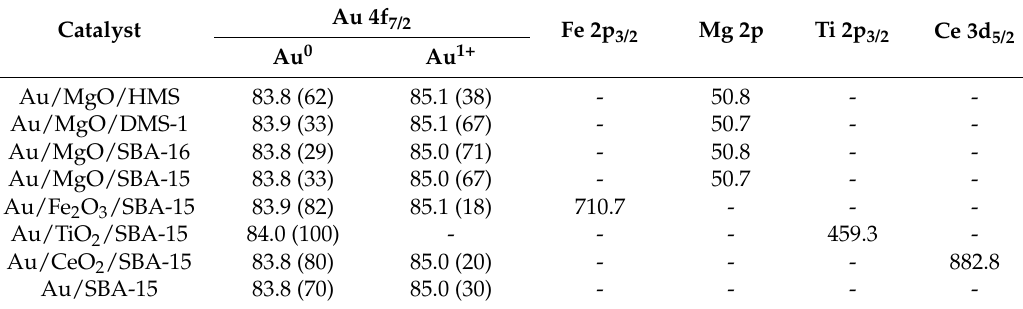
Table 3. Binding energies (eV) of core electrons of the dried Au catalysts (from XPS).